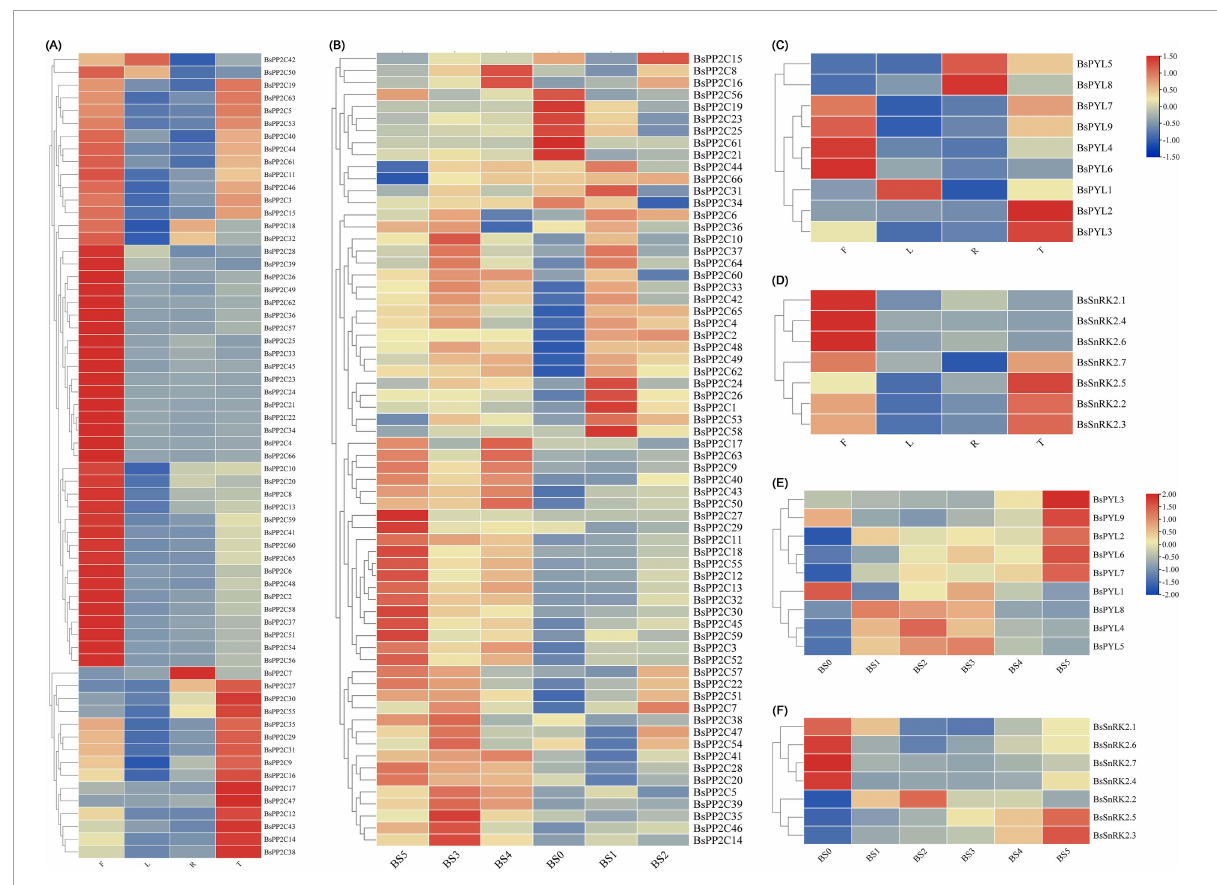
FIGURE4 Expression profile heatmap with hierarchal clustering of BsPP2Cs (A,B) , BsPYLs (C,E) , and BsSnRK2s (D,F) in different tissues and different germination stages of B. striata . R, T, L, and F in panels (A,C,D) represented root, pseudobulb, leaf, and flower, while BS0 ∼ BS5 represented different germination stages, respectively. The relative expression for each genes is depicted by color intensity in each field. Higher values are represented by red whereas lower values are represented by